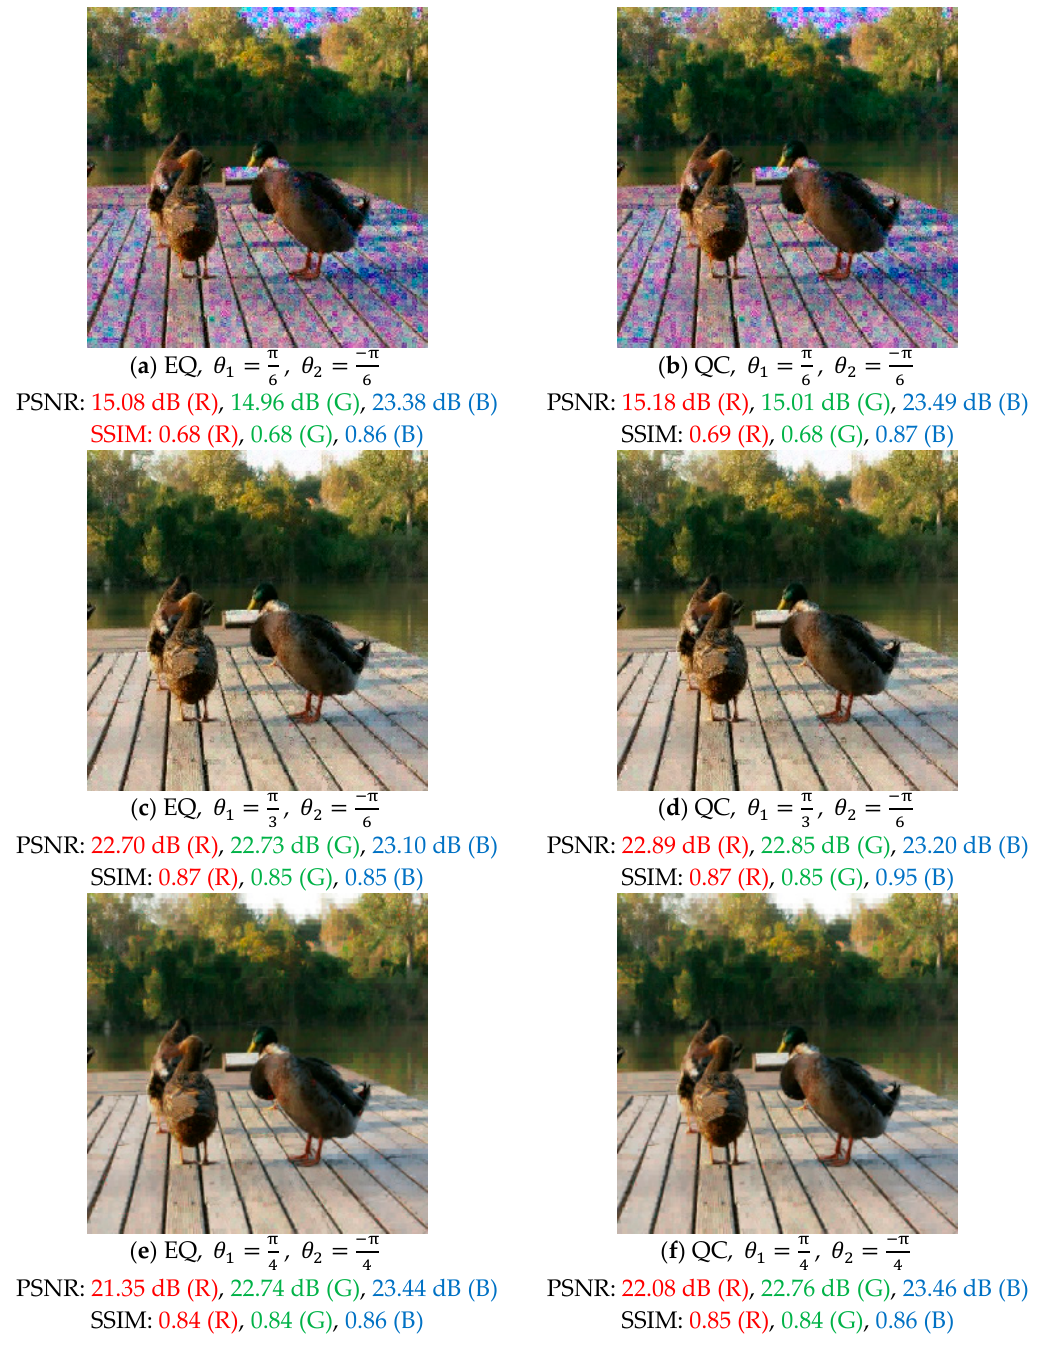
Figure 10. Demonstration of angle selection in multiple description coding with equality and quadratic constraints. BCS coefficients experienced a lossy rate of p e ,1 = p e ,2 = 0.1 in three